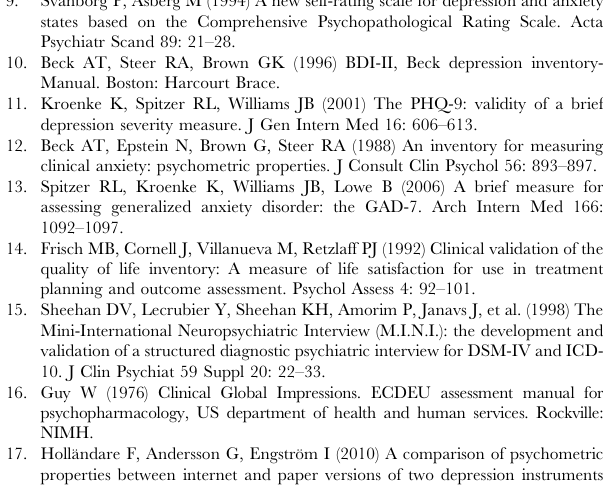
Protocol S1 Original study protocol, translated to